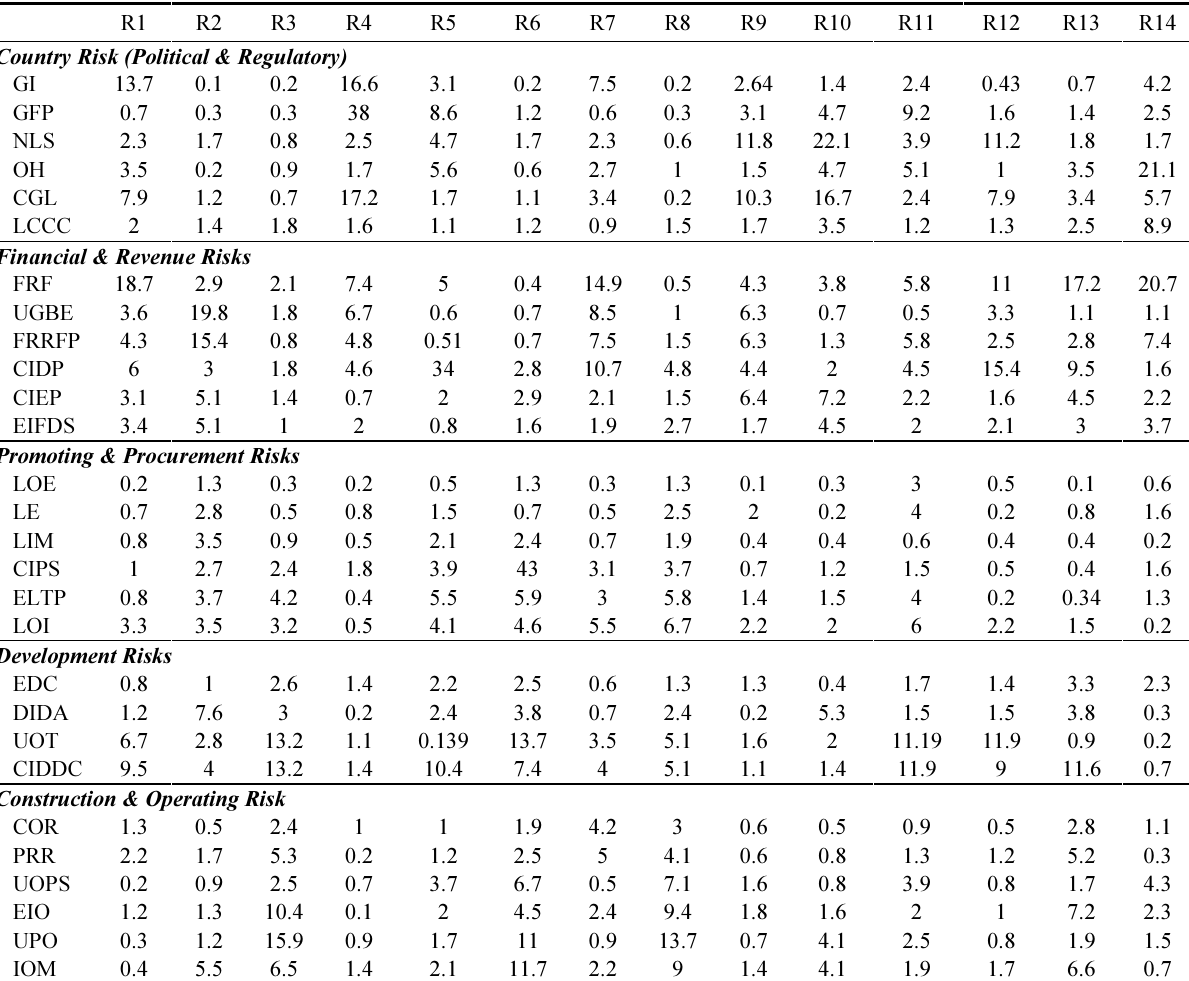
Table 7. Local composite weights of the attribute towards the project risk (×10E-2) R1